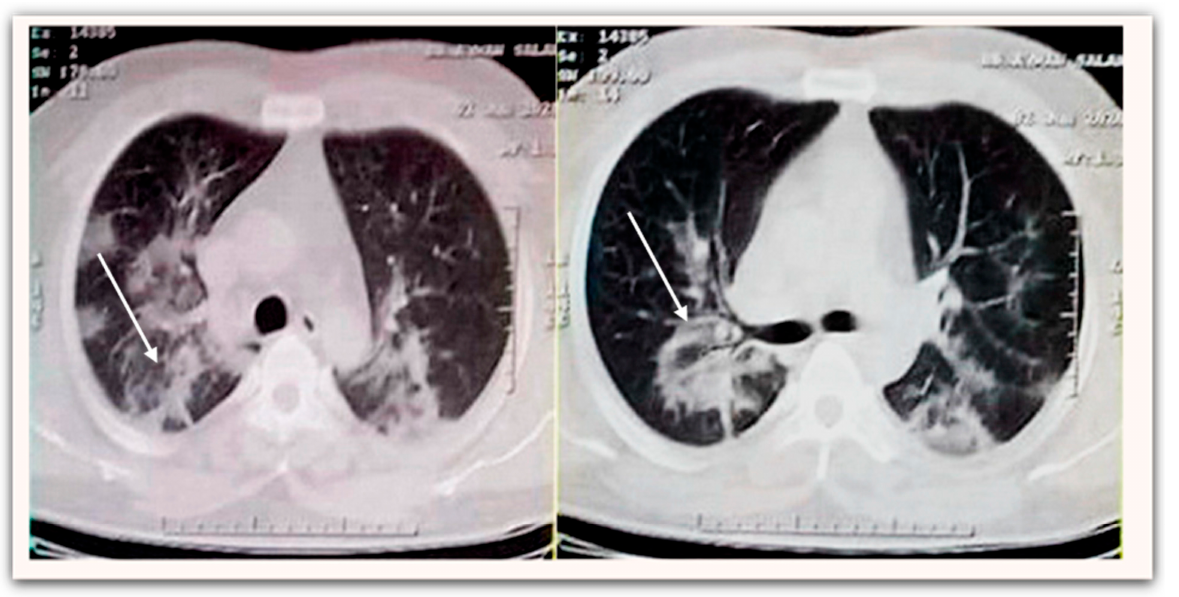
Figure 1. Non-enhanced chest CT scan demonstrates bilateral peripheral ill-defined patchy ground- glass opacities at both lower lung fields ( white arrow ). Table 2. Sequential Organ Failure Assessment (SOFA) Score.